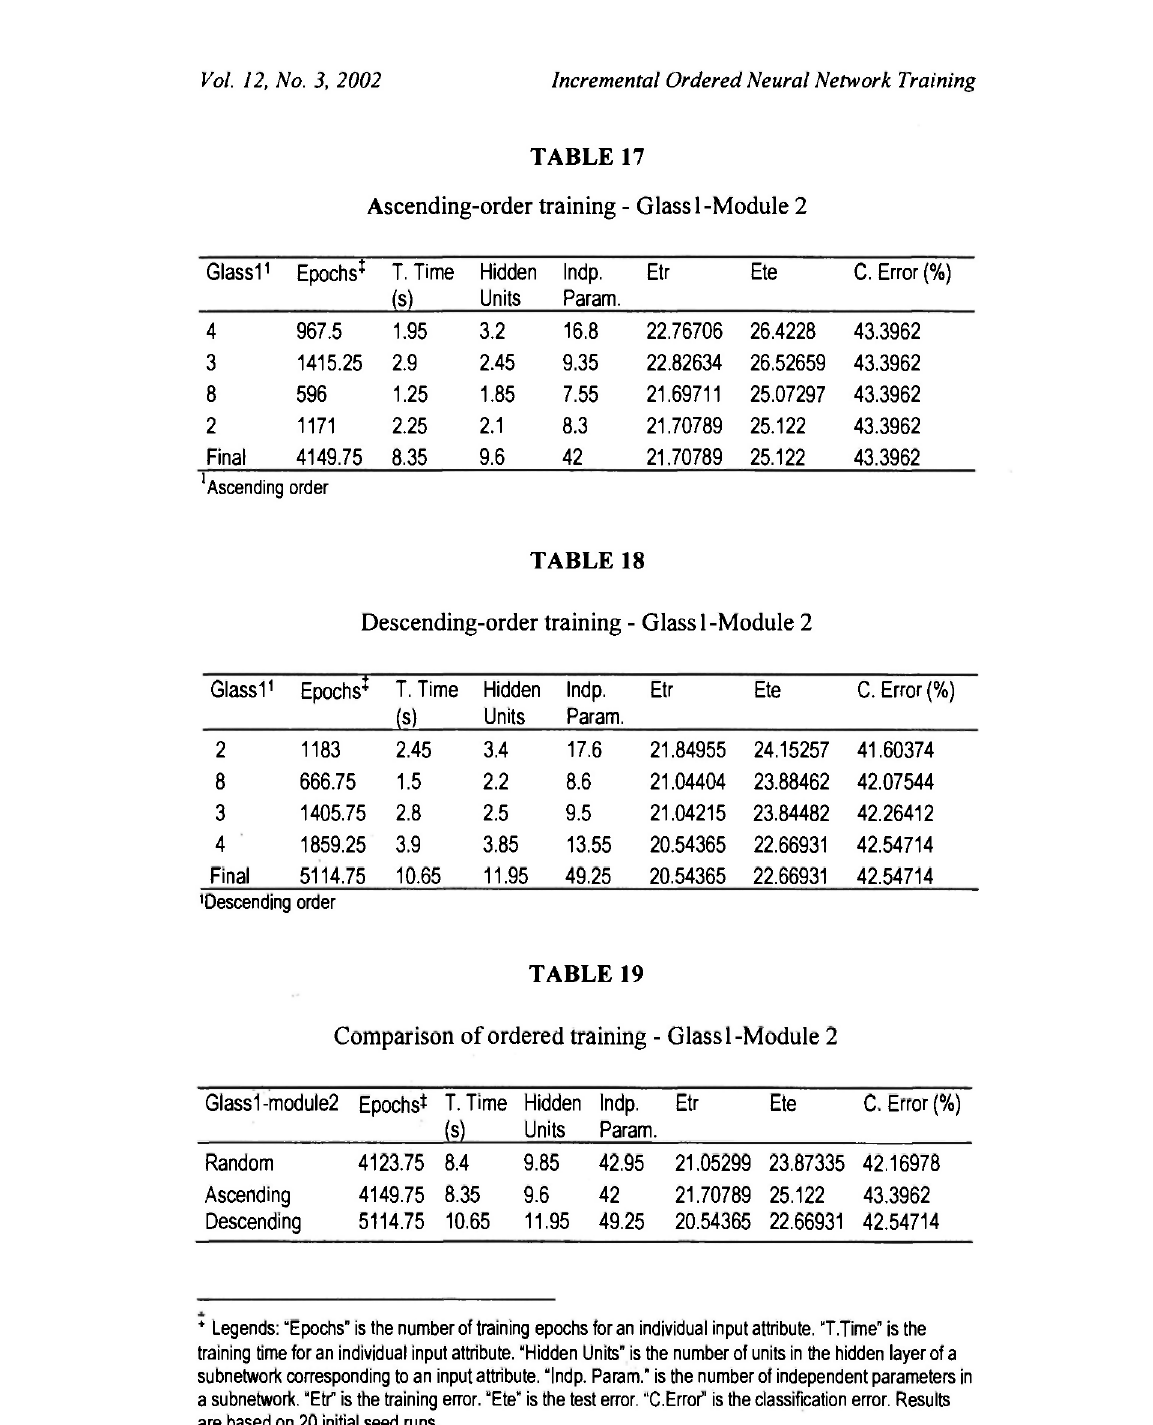
Comparison of ordered training - Glass 1-Module